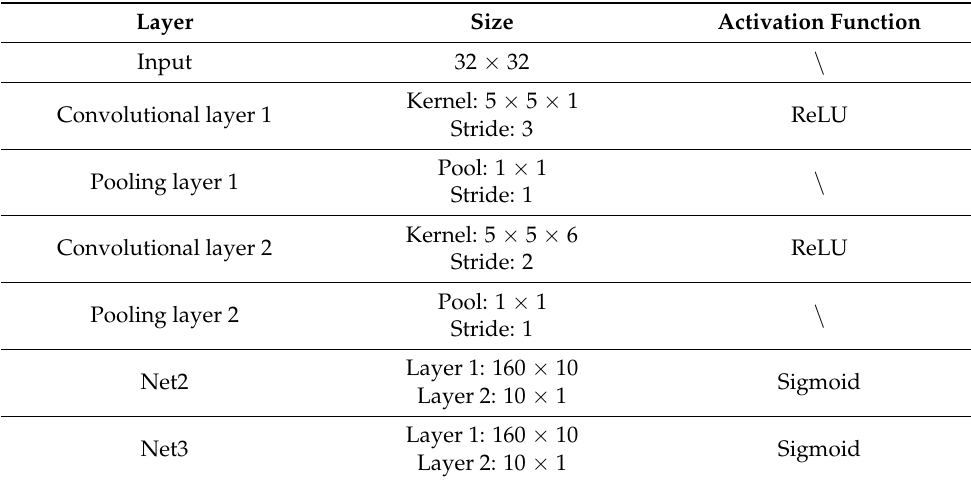
Table 2. Parameters set of the network.